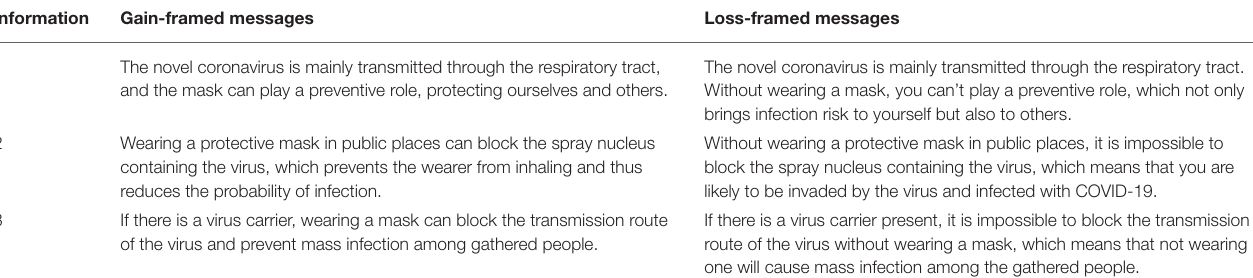
TABLE 1 | Stimulation information used in the questionnaire.